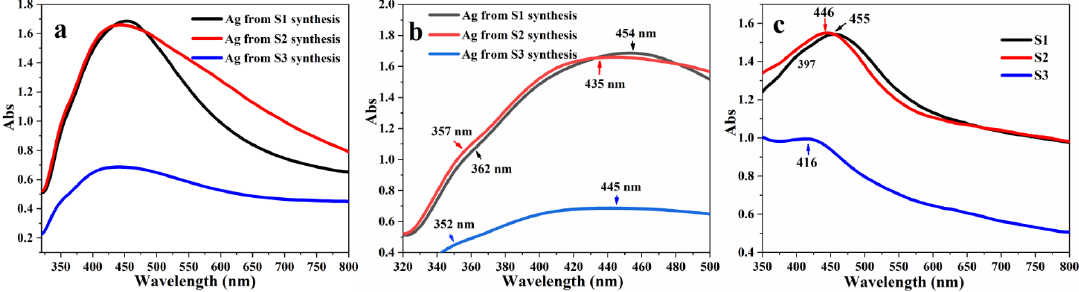
Figure 9. UV-vis spectrum of ( a ) colloidal Ag NPs from synthesis process of S1, S2 and S3 and ( b ) enlargement of Figure 9a and ( c ) dried samples of S1, S2 and